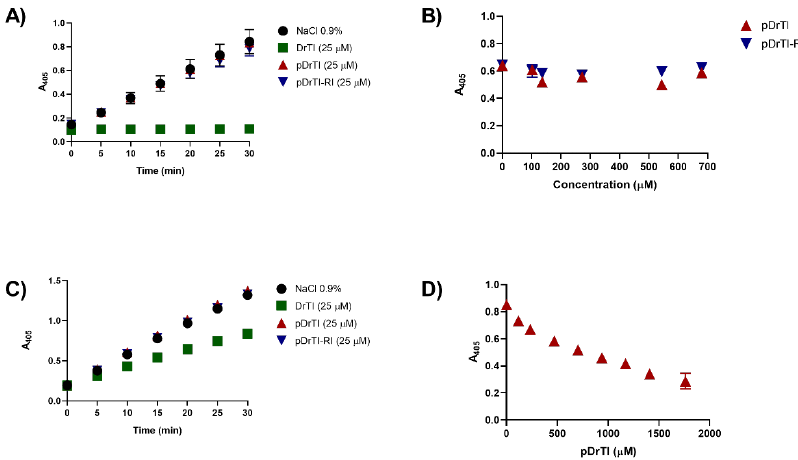
Figure 1. Inhibitory activity—Bovine trypsin (37 nM) activity was performed with the synthetic substrate BAPNA (Bz-Arg-pNA). Substrate hydrolysis was measured through p-nitroaniline release by reading on a plate spectrophotometer at a wavelength of 405 nm every 5 min ( A ) or the end of the 30 min ( B ) with different concentrations of the peptides under study. PKa (14.7 nM) activity was performed with the synthetic substrate HD-Pro-Phe-Arg-pNa. Substrate hydrolysis was measured through p-nitroaniline release by reading on a plate spectrophotometer at a wavelength of 405 nm every 5 min ( C ) or the end of the 30 min ( D ) with different concentrations of the peptides under study. Assays were done in triplicate.